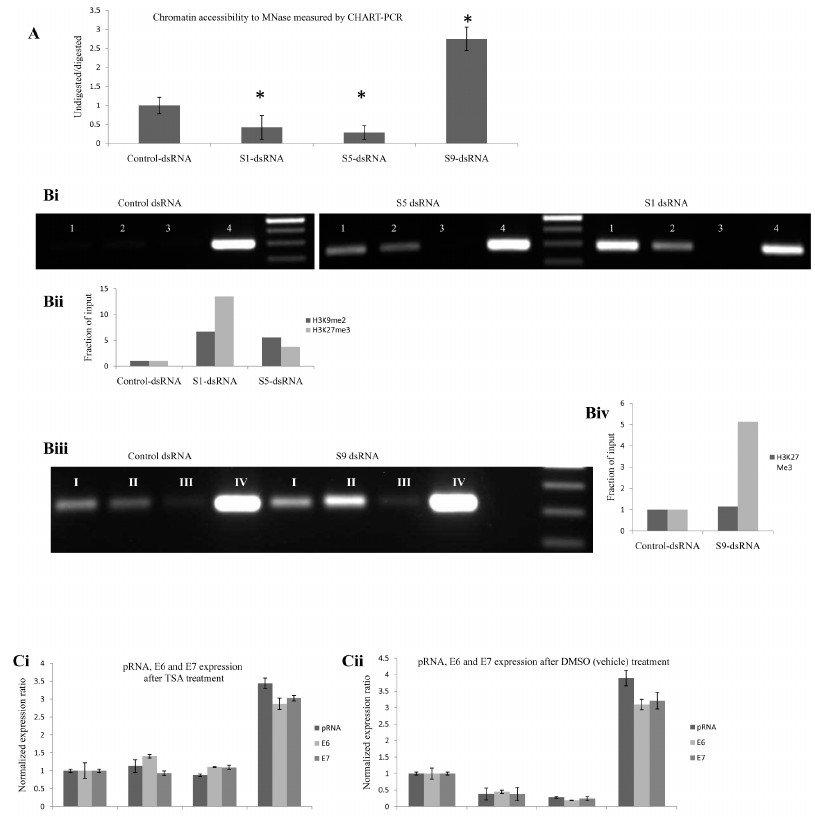
Fig 8. Epigenetic modifications post dsRNA transfection. (A)Chromatin remodeling after S1, S5 or S9 dsRNA transfection. Significant reduction in MNase digestion 72 hours after S1 and S5 transfection while increase in the accessibilty after S9 transfection in HeLa cells. Cells were transfected with the respective dsRNAs followed by MNase-PCR 72 hours post transfection. S1:S1 dsRNA transfected cells, S5-dsRNA: S5 dsRNA transfected cells, S9-dsRNA: S9 dsRNA transfected cells, Control-dsRNA: Control dsRNA transfected cells ( * ) P < 0.01. Bi-Biv. Enrichment of H3K9me2, H3K27me3 and H3K4me2 at dsRNA target sites. dsRNA induced TGS is associated with increase in H3K9me2 and H3K27me3 while TGA is associated with gain in H3K4me2. HeLa cells were transfected with respective dsRNAs followed by ChIP analysis 72 hours later using the desired antibodies to pull the target DNA. Precipitated DNA was analyzed by PCR using region specific primers. DNA pulled down in the absence of antibody (mouse IgG) served to identify background amplification while input DNA was amplified as a loading Control. (Bi) Gel electrophoretogram showing PCR products obtained after ChIP in S1 and S5 dsRNA transfected cells. (Biii) Gel electrophoretogram showing PCR products obtained after ChIP in S9 dsRNA transfected cells. (Bii and Biv) Densitometric analysis of ChIP data shown in A and B, obtained with ImageJ software. Relative enrichment = ChIP/Input DNA. 1: H3K9me2 immunoprecipitated PCR, 2 and I: H3K27me3 immunoprecipitated PCR, 3 and III: mouse IgG immunoprecipitated PCR, 4 and IV: Input DNA, II: H3K4me2 immunoprecipitated PCR. Ci-Cii. Effect of HDAC inhibition on TGS and TGA. Expression ratio of pRNA, E6 and E7 after S1, S5 or S9 transfection. HeLa cells were transfected with dsRNA (100nM) and 24 hours later treated with DMSO or TSA (400nM) followed by RNA isolation 48 hours after the treatment. (Ci) TSA treatment in dsRNA transfected cells. (Cii) DMSO (solvent for TSA and AZA) treatment in dsRNA transfected